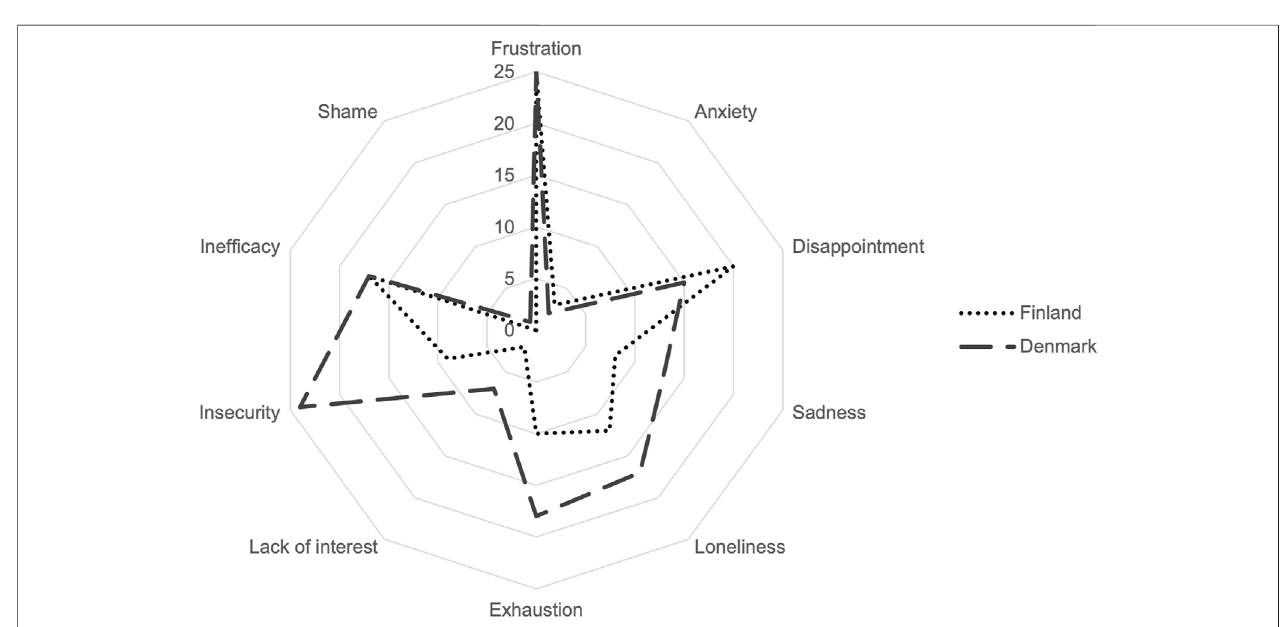
FIGURE 2 | Cross-country comparison of negative